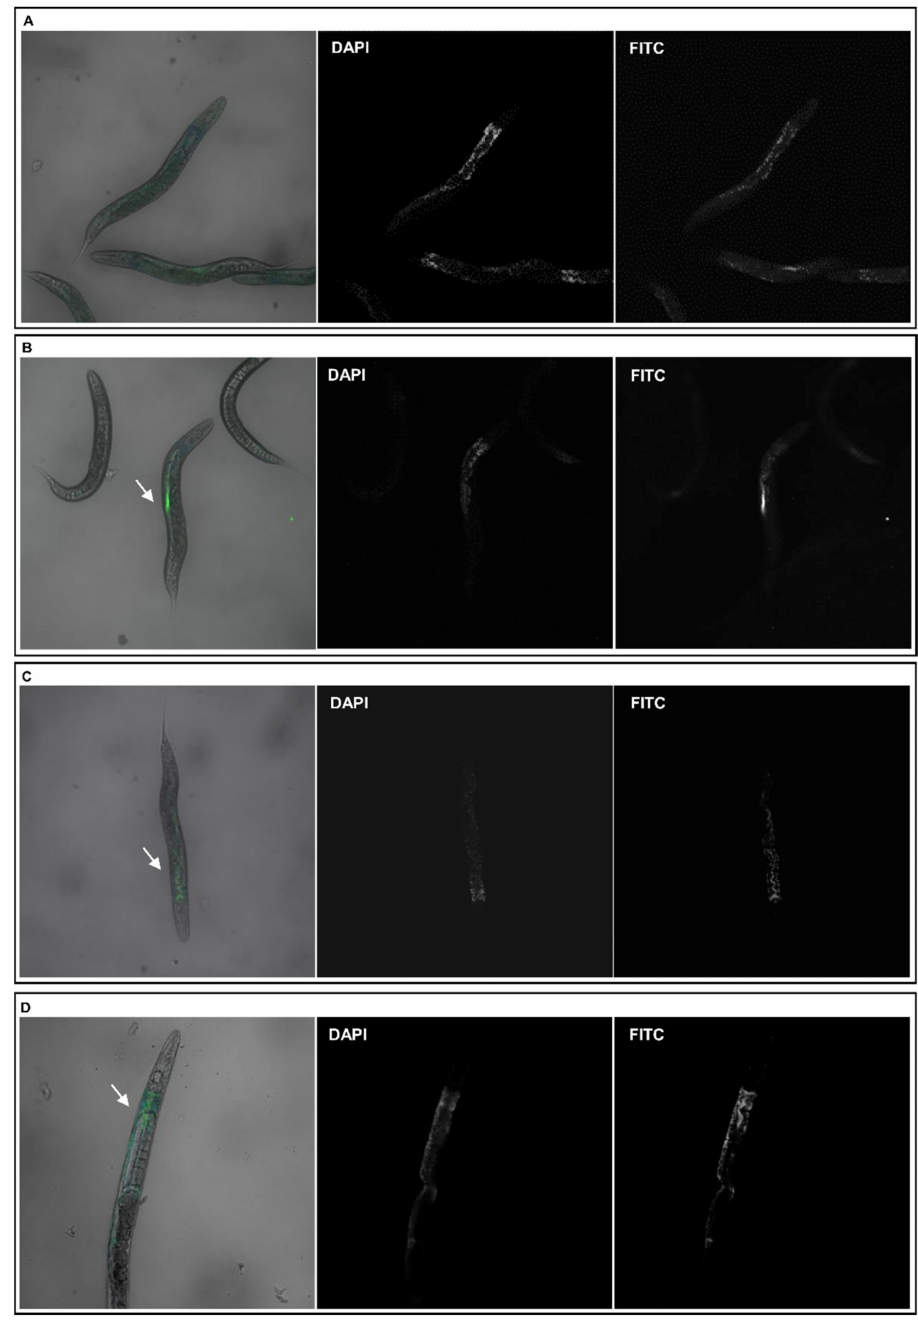
Figure 3. Representative confocal fluorescence micrographs of worms treated with FITC-NPs. Left column: DAPI and FITC merge; mid: DAPI; right: FITC. Worms were treated for 2 h at 20 ◦ C under gentle agitation with the following NPs: ( A ) no addition; ( B ) MYTS, ( C ) MYTS-PEG; ( D ) MYTS-EDBE. Arrows indicate FITC-NPs